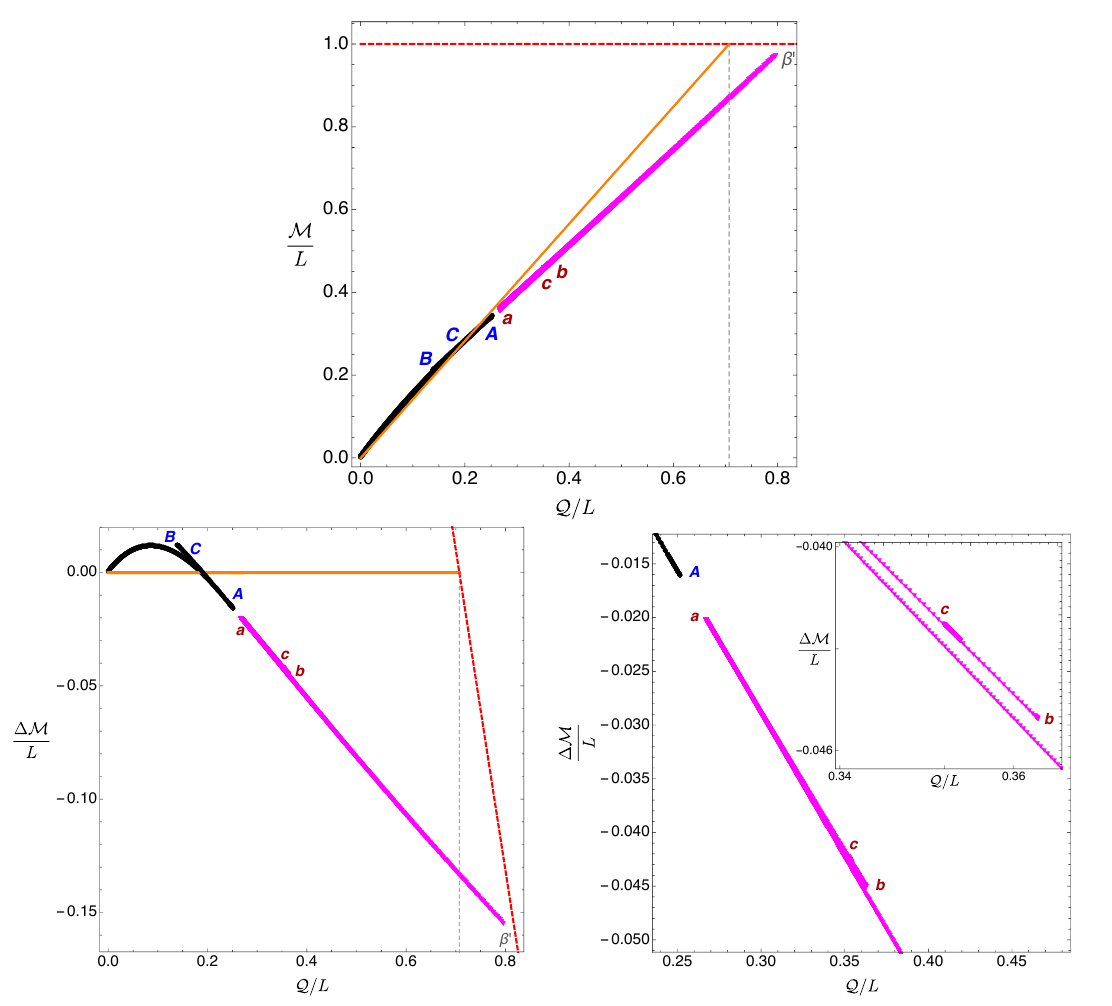
Figure 6 . Soliton families with e = 1 . 854 ( e γ < e < e c ). Top panel: quasilocal mass vs charge. The main family (black curve OABC · · · ) looks to be on top of the extremal RN BH (orange line) which is why we find it useful to plot the quantity ∆ M which is shown on the bottom panel. Bottom-left panel: the main black soliton curve starts more massive ( ∆ M > 0 ) than the extremal RN but then becomes less massive ( ∆ M < 0 ) above a certain charge. The secondary soliton family (magenta curve) eventually hits the dashed red line at β 0 and extends to a finite lower charge Q where it develops a series of cusps a, b, c, · · · . Bottom-right panel: zoom of the left plot to amplify the gap Aa between the main and secondary families (magenta) and the cusp structure abc · · · of the secondary